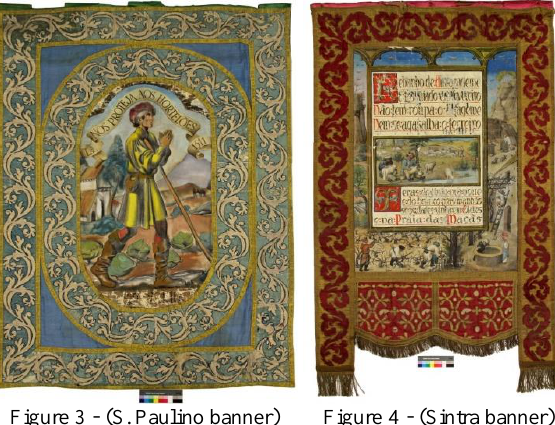
Figure 3 - (S. Paulino banner) Figure 4 - (Sintra banner)